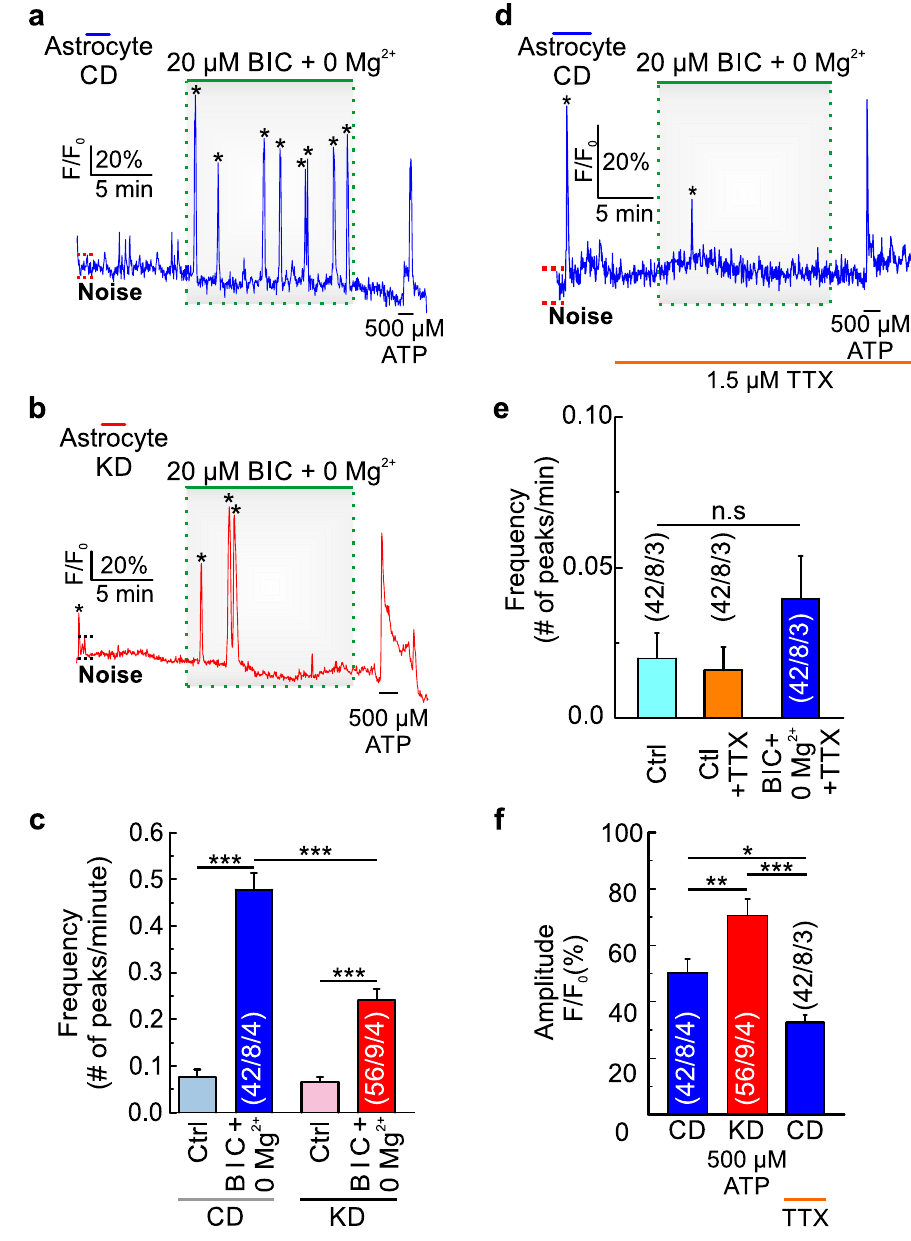
Figure 1. Epileptiform activity is reduced by the action of the ketogenic diet in cortical slices. Changes in astrocytic Ca 2 + signals, as induced by neuronal epileptiform activity (0 Mg 2 + /BIC) in cortical slices in CO 2 / HCO 3 − -buffer from mice that followed a control ( a ) and a ketogenic diet ( b ) in the absence of TTX, and from mice fed with a control diet in the presence of TTX ( d ). One short pulse of ATP was given at the end of each measurement to verify astrocytic Ca 2 + response. Frequency of the peaks occurred spontaneously (ctrl; light blue and light red bars), and induced by BIC/0Mg 2 + in CO 2 /HCO 3 − -buffer, in slices from mice that followed control (blue bar) and ketogenic (red bar) diets in the absence of TTX ( c ), and in slices from control mice in the presence of TTX ( e ). Amplitude of the peaks induced by ATP in astrocytes from control (blue bar) and ketogenic mice (red bar) in the absence of TTX, and from control mice in the presence of TTX ( f ). Statistical values are presented as means ± S.E.M. Significance was tested with paired Student’s t-test. Number of astrocytes/slices/mice used are indicated in the bar